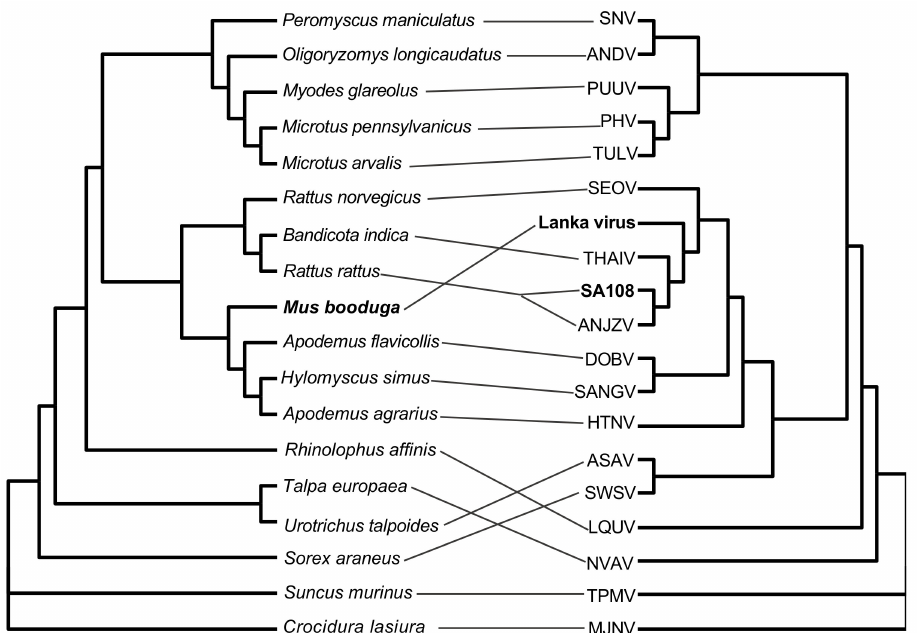
Figure 3. Tanglegram comparing the phylogenies of the representative hantaviruses and their hosts. The phylogeny of viruses based on amino acid sequences of the N protein (on the right) is compared with the cytb sequence-based phylogeny of their hosts (on the left). The newfound viruses are